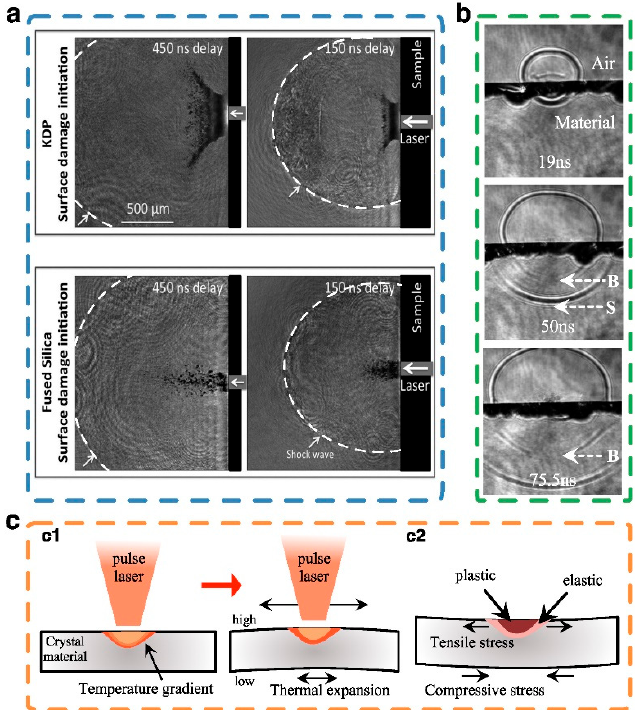
Figure 19. The effect and distribution of stress. ( a ) Comparison of the shockwave in fused silica and KDP. The shockwave propagating is denoted by an arrow [94]; ( b ) Propagation of shockwaves in materials. The shock front (S), back-pressure induced shock wave (B); ( c ) Analysis of the stress action on crystal material under laser irradiation [95]. c1 The distribution of thermal stress due to temperature gradient and expansion; c2 The deformation of crystal materials under tensile stress [87].